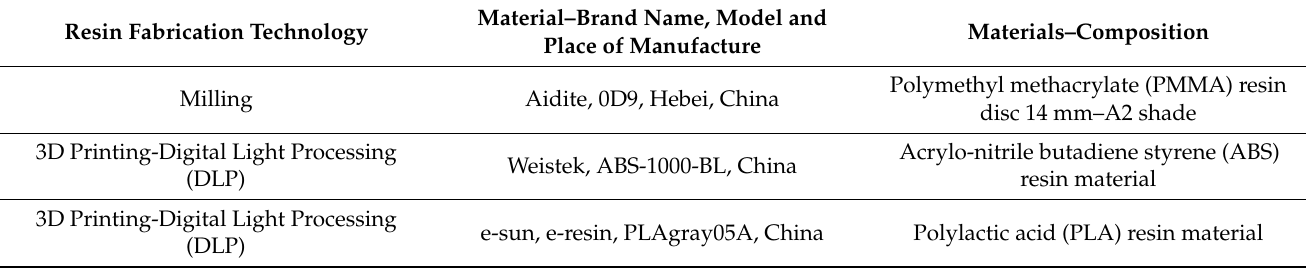
Table 1. Materials and techniques used for pattern fabrication.